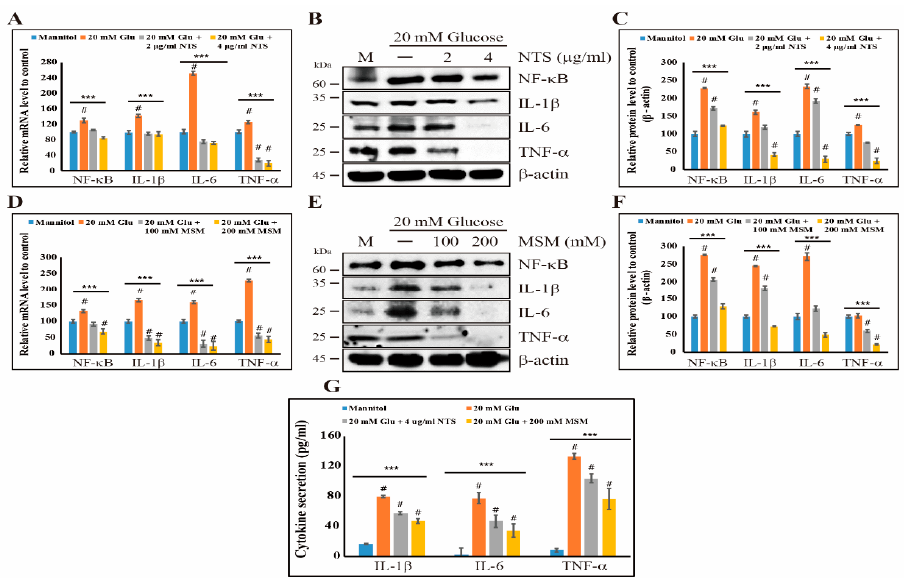
Figure 4. Sulfur compounds inhibit NF- κ B and proinflammatory cytokines. ( A ) The mRNA expression levels of NF- κ B, IL-1 β , IL-6, and TNF- α in THP-1 cells were detected by real-time PCR after treatment with 20 mM glucose and NTS (2 and 4 µ g / mL) for 24 h and normalized to GAPDH mRNA. The values are presented as means ± SEM of three independent experiments performed in duplicate ( n =